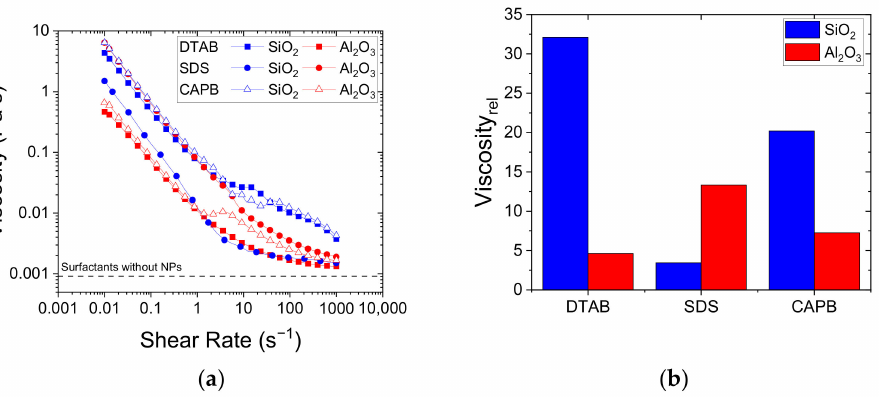
Figure 3. ( a ) Flow curves of solutions containing DTAB, SDS, or CAPB in the presence of 1.0 wt % NPs and ( b ) their relative viscosities (ratio of viscosities with and without NPs) at a shear rate of 10 s − 1 . However, the viscosity values did not show a direct correlation with the foam half-life: DTAB/SiO 2 had the highest viscosity, whereas CAPB/SiO 2 showed the longest foam t 1/2 (846 s). A better correspondence was found considering the relative foam half-life ( t 1/2 rel